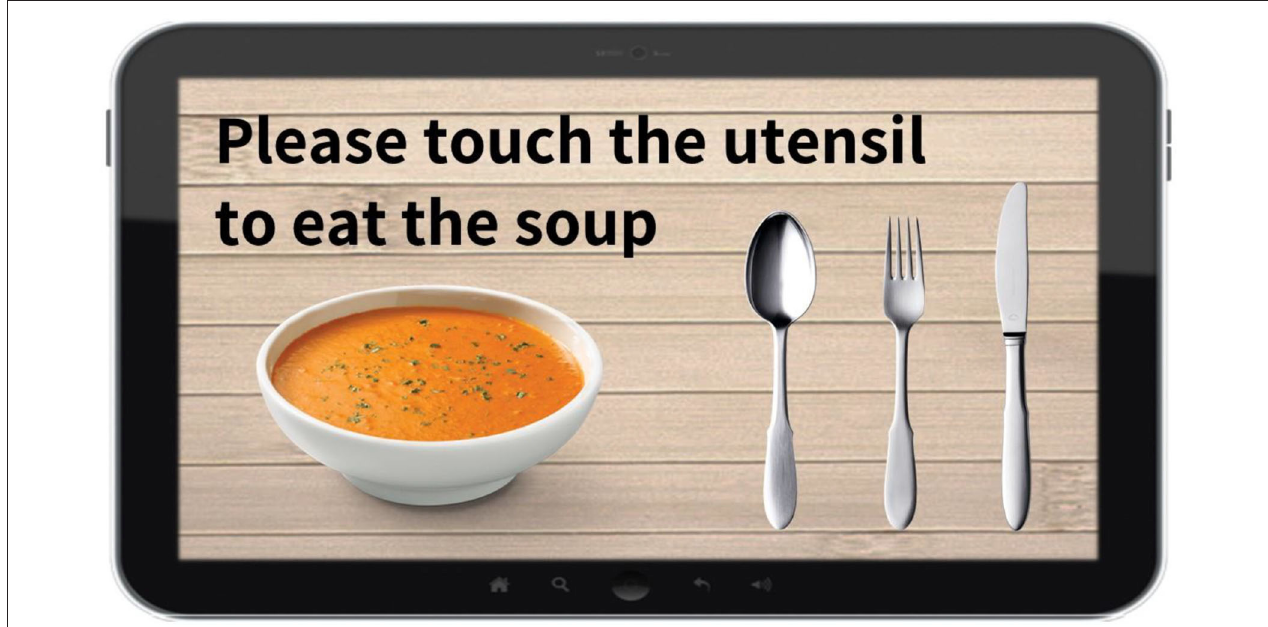
FIGURE 1 | Depiction of game